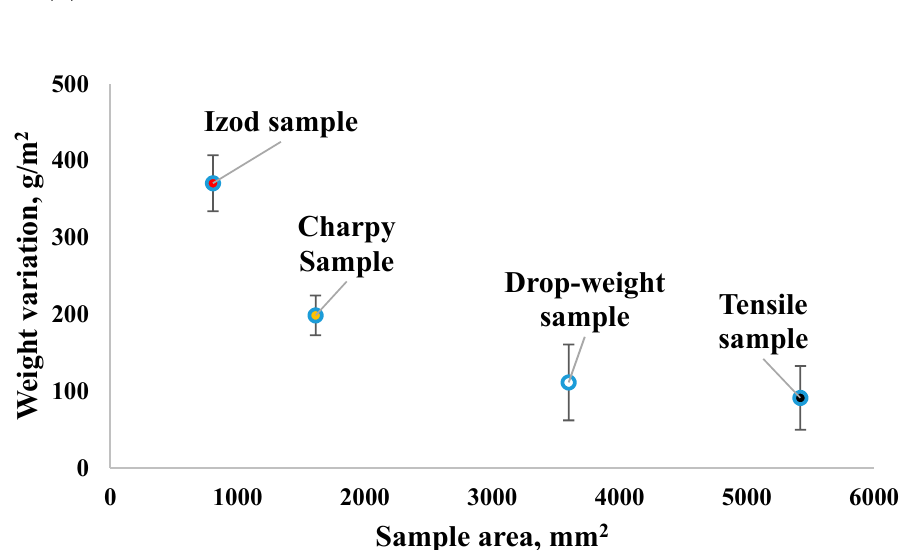
Figure 6. Variation in weights between estimated (by software) and measured for di ff erent sample sizes.